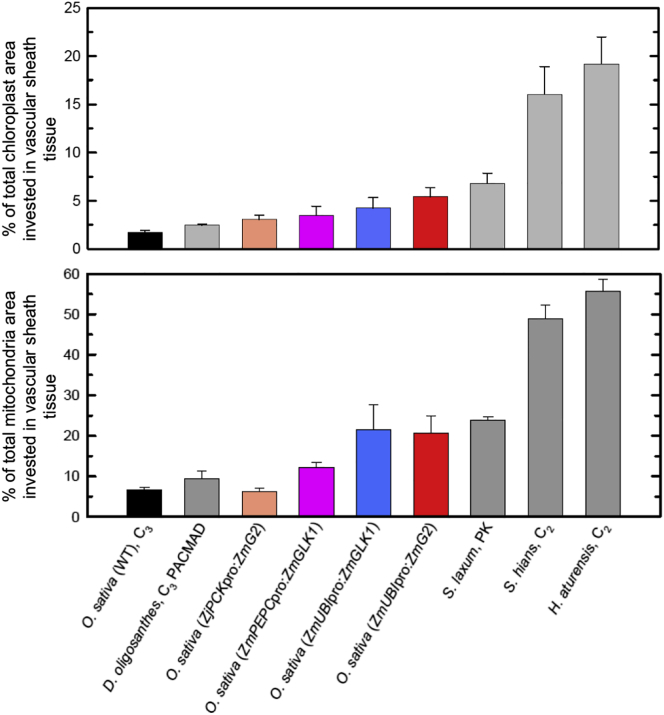
Percentage of Planar Organelle Area Invested in Vascular Sheath Cells Is Equivalent to that in Proto-Kranz Grass SpeciesPercentage of total planar chloroplast (top) and mitochondrial (bottom) area in vascular sheath cells of wild-type (WT) and transgenic rice lines, plus PACMAD grasses Dicanthelium oligosanthes (C3), Steinchisma laxum (proto-Kranz [PK]), S. hians (C2), and Homolepis aturensis (C2). Values are mean ± SEM (n = 3). The trend toward proto-Kranz correlates with levels of transgene expression. Both ZmUBIpro:ZmG2 and S. laxum (PK) have significantly greater investment of chloroplasts and mitochondria in vascular sheath tissue than WT by a one-tailed t test (p < 0.05). No significant differences were observed between ZmUBIpro:ZmG2 and S. laxum (PK) by one-tailed or paired t tests (p > 0.2). See Figures S1 and S2 and Table S1 for transgene details and transcript levels in lines examined, Table S5 for a complete set of measurements, and Figure S4 for equivalent graphs of C3, PK, and C2Flaveria spp.